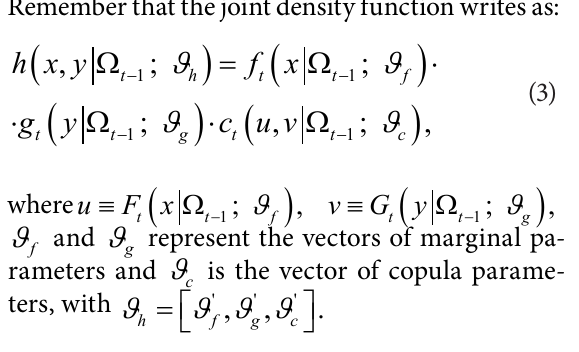
ϑ and ϑ represent the vectors of marginal f g